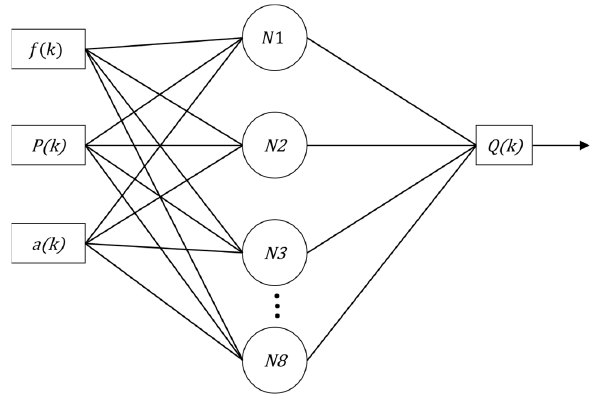
Figure 11. Diagram of Multi-layer Perceptron Feedforward Backpropagation ANN without feedback, with three input vectors, eight neurons and an output.